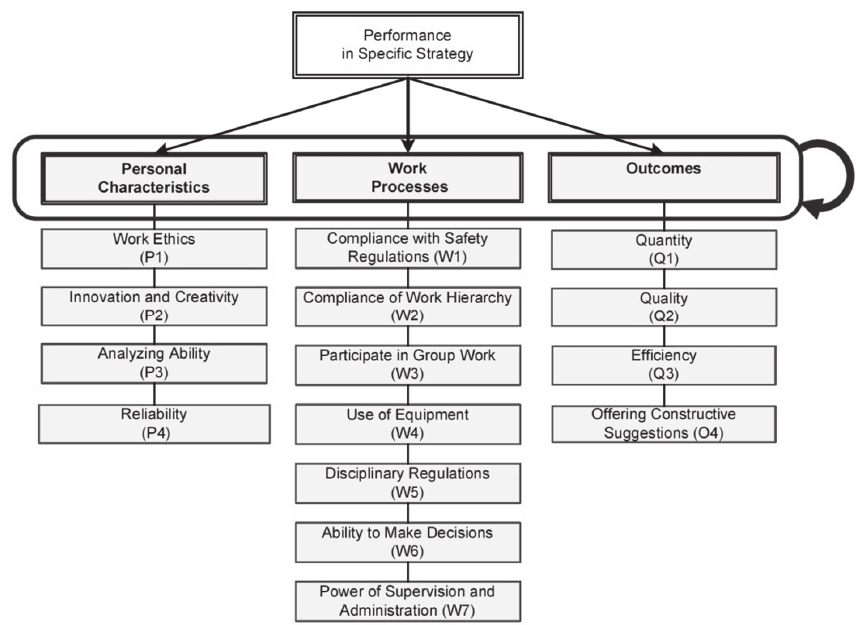
Fig. 6. The proposed ANP model for measurement of